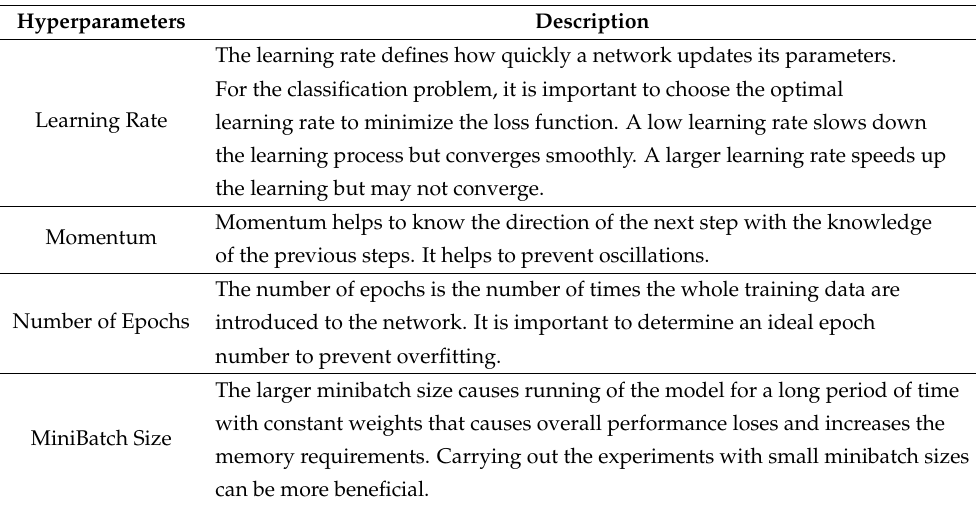
Table 1. Hyperparameters related to the training of a neural network